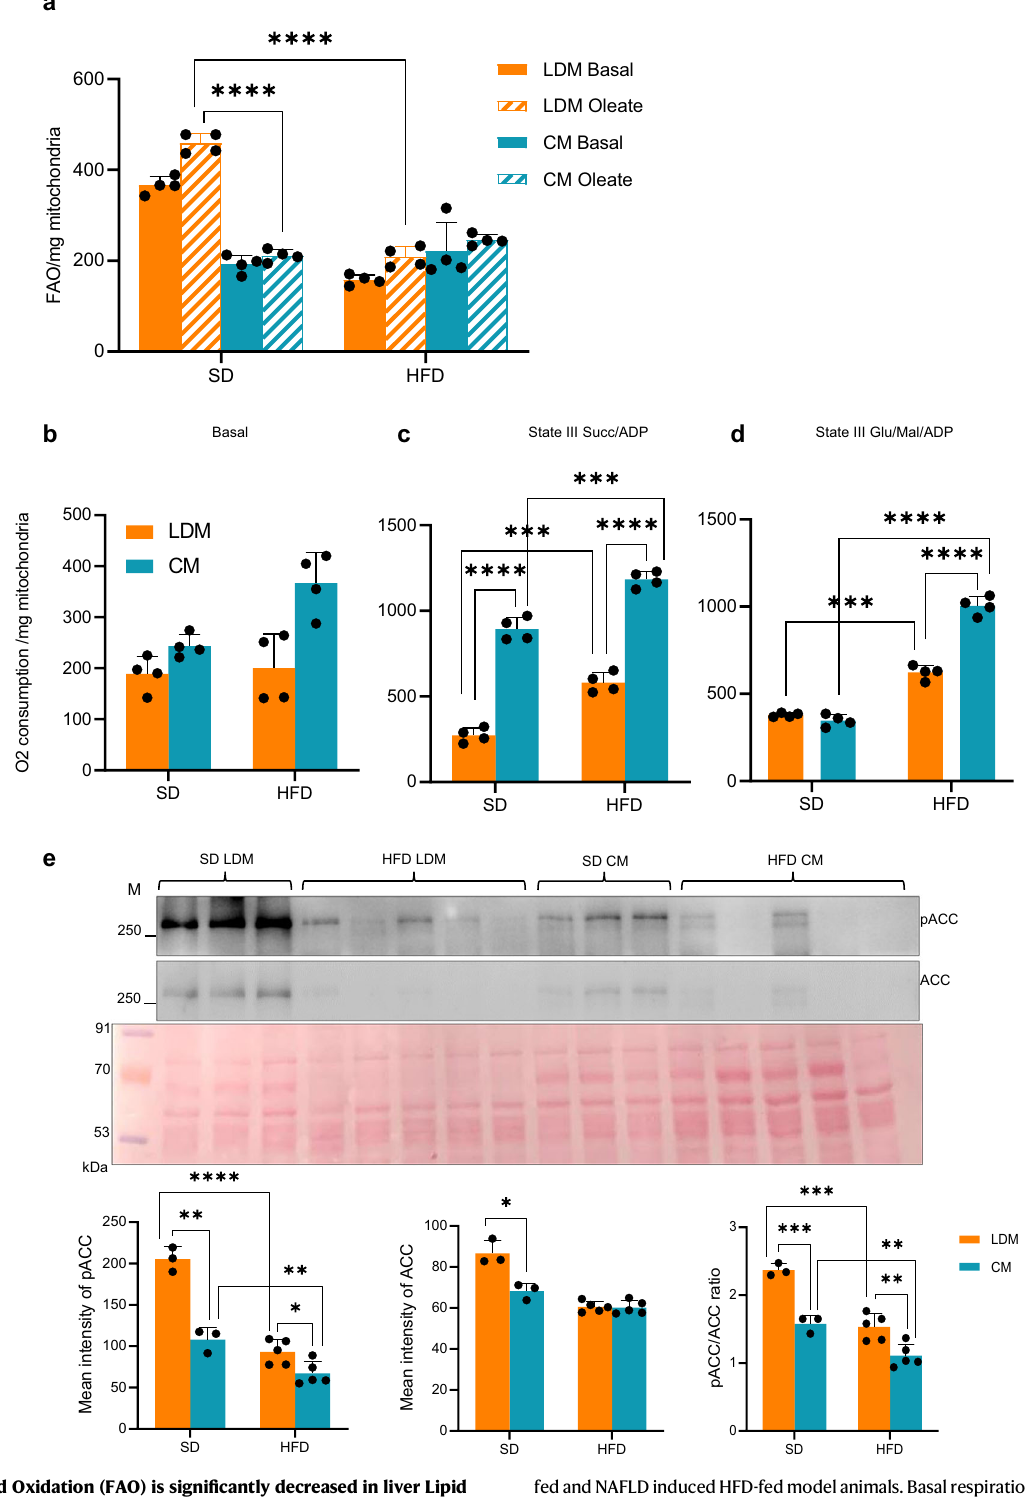
fedandNAFLDinducedHFD-fedmodelanimals.Basalrespirationintheabsenceof any substrate and State III respiration in the presence of Succinate+ADP or Glu- tamate/Malate+ADP were monitored in CM and LDM samples isolated from con- trolSD-fedandNAFLDinducedHFD-fedmodelanimals.( n =4).Dataarepresented asmeanvalues±SD.Signi fi cancewascalculatedbytwotailed un-pairedStudent t - test. **** P <0.0001, *** P <0.001. e Total and phosphor ACC levels are signi fi cantly decreased in LDM and CM of NAFLD. Westernblot ( n =3 for SDand n =5 for HFD) probedwithantibodiesagainstphosphorylatedACC2(pACC2)andACC2.Dataare presented as mean values+/ − SD. Signi fi cance was calculated by two tailed